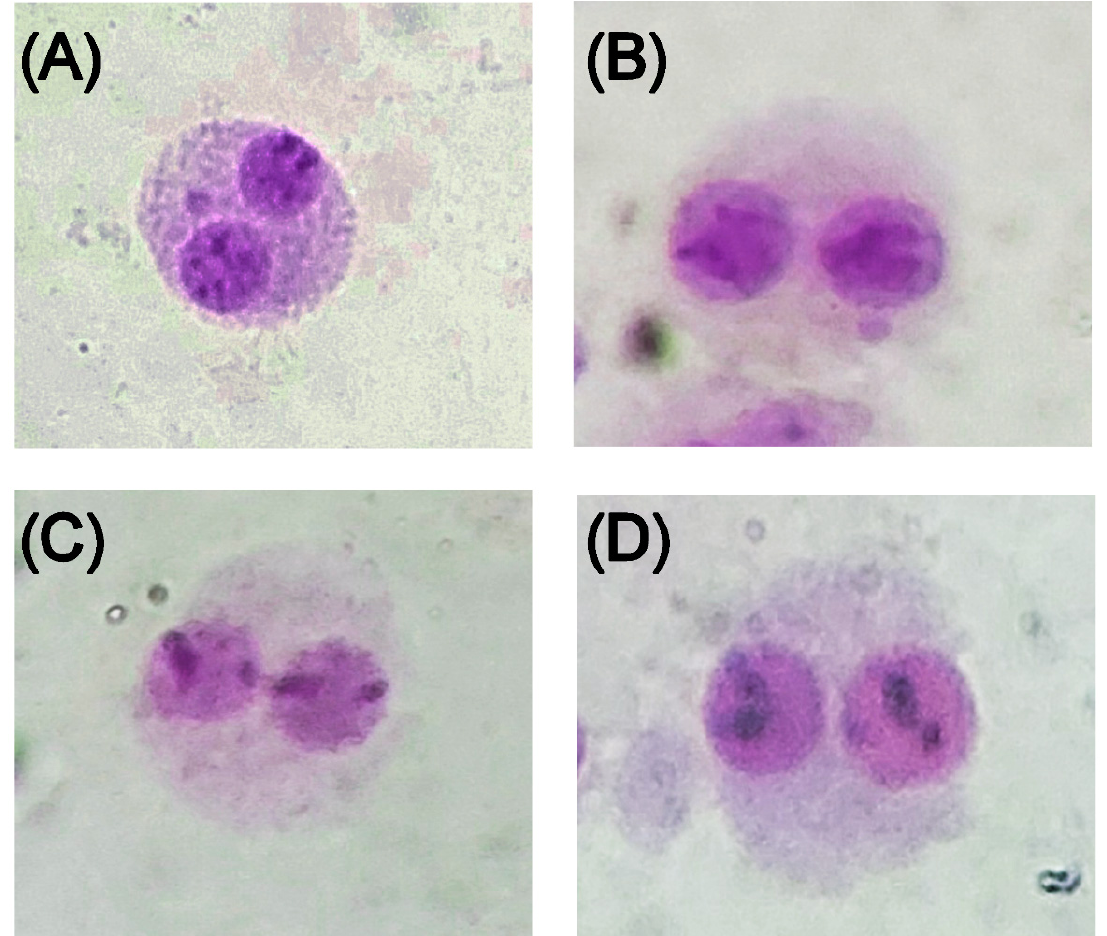
Figure 5. Micrographs showing binucleated cells in the lymphocyte cytokinesis-block micronucleus assay classified as ( A ) micronuclei (MNi); ( B ) nuclear buds (NBUDs); ( C ) nucleoplasmic bridges (NPBs); and ( D ) binucleated cells.